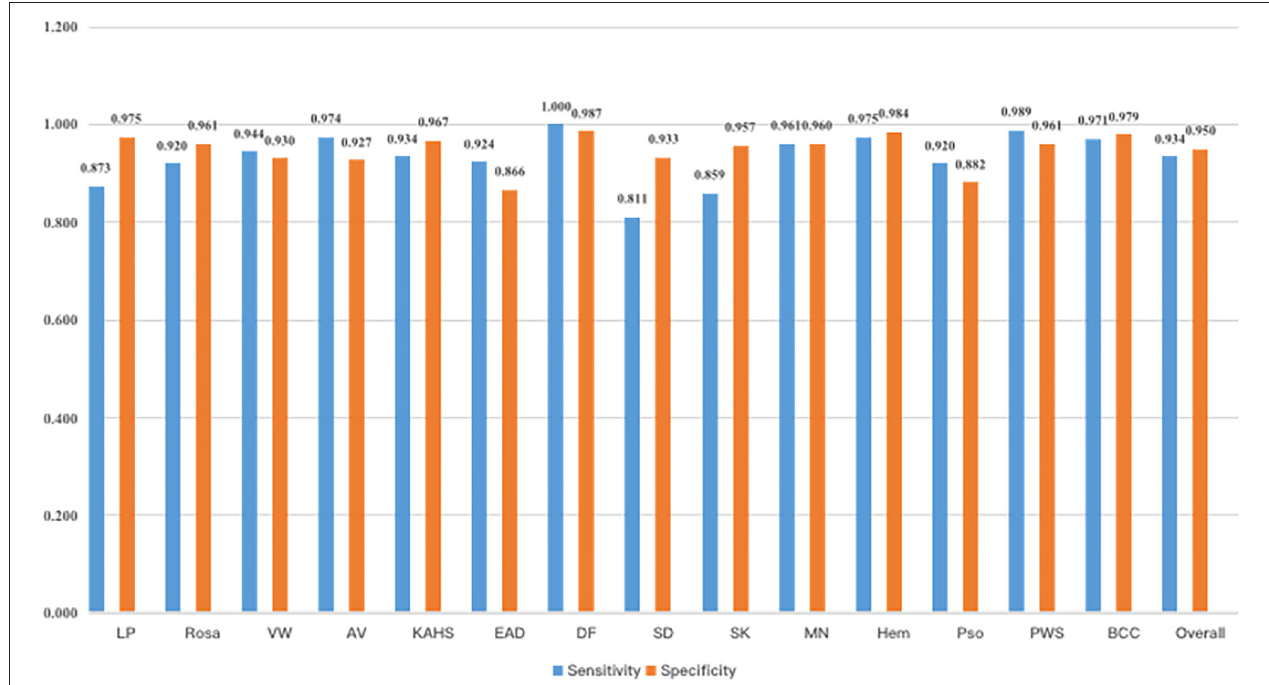
FIGURE 4 | Sensitivity and specificity of our model. As a result, our model had an overall sensitivity of 93.38 ± 0.08% and specificity 94.85 ± 0.05%.